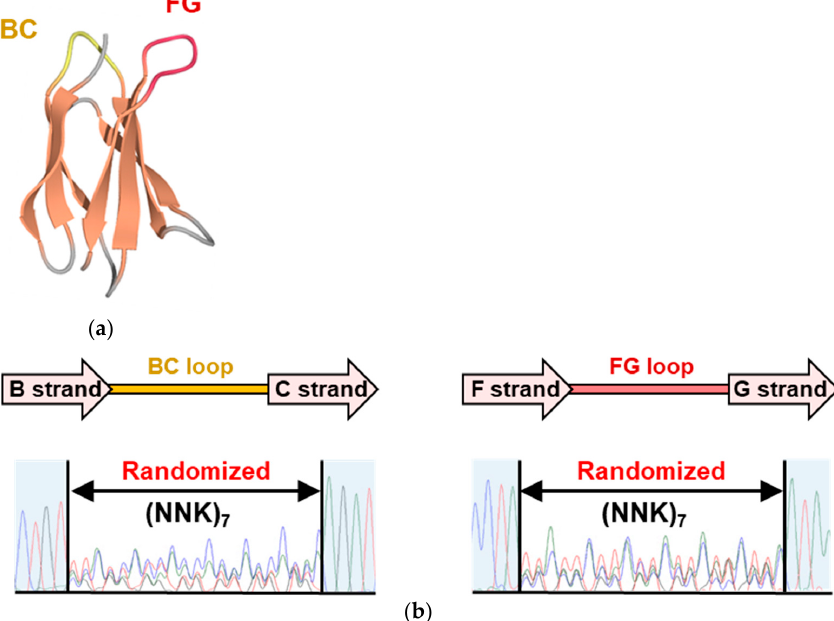
Figure 1. Construction of an adnectin-derived phage display library: ( a ) structure of an antibody mimic molecule adnectin. Randomized sequences at seven constitutive residues were introduced in BC and FG loops which were known to play important roles for target-binding; ( b ) sequence analysis of BC and FG loops of the constructed adnectin library.